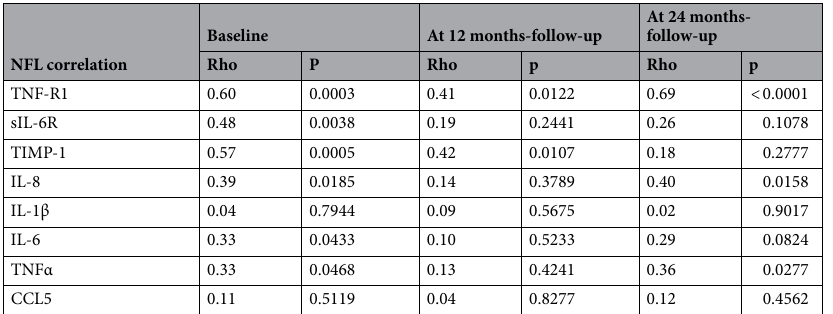
Table 3. Correlations between NFL and inflammatory markers at baseline, 12 and 24 months of follow–up. TNF-R1, tumor necrosis factor receptor 1; sIL-6R, soluble interleukin 6 receptor; TIMP-1, tissue inhibitor of metalloproteinases 1 ; IL-8, interleukin 8 ; NFL, neurofilament light protein; IL-1β, interleukin 1β; IL-6, interleukin 6; TNFα, tumor necrosis factor α; CCL5, chemokine ligand